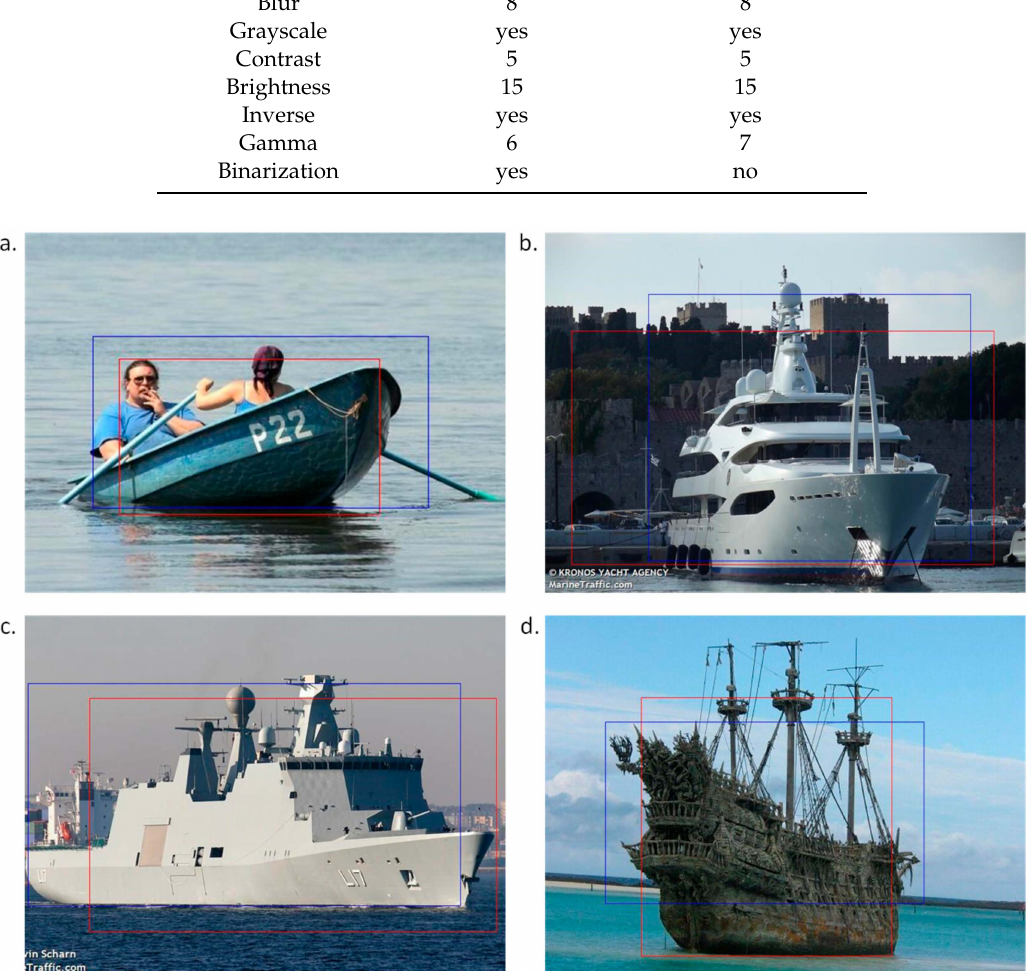
Figure 2. Sample examples of images, where the rectangles indicate the extracted images: ( a ) boat; ( b ) motor yacht; ( c ) navy ship; and ( d ) historic